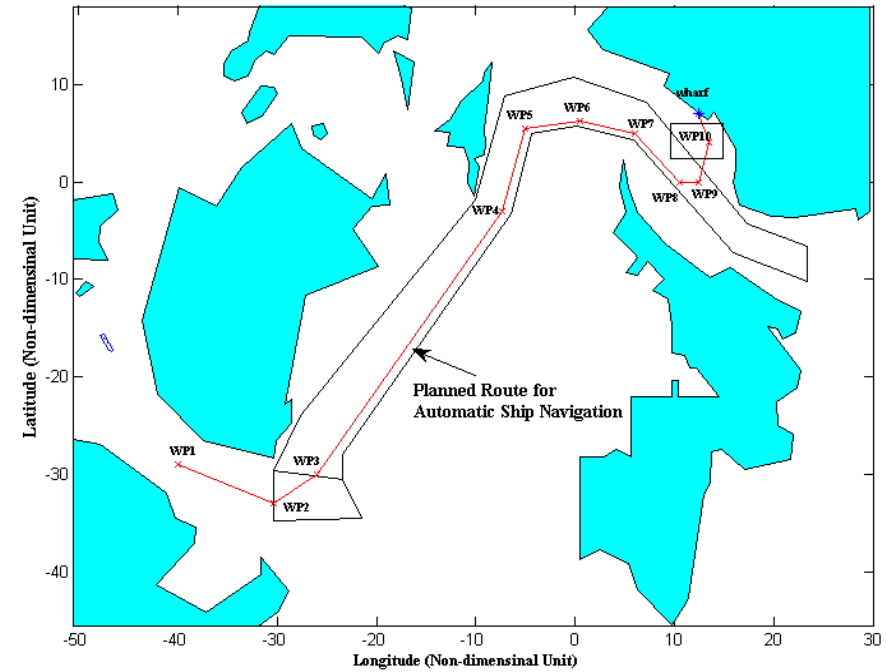
Figure 9. Mokpo fairway simulation planned route after normalizing the latitude and longitude.